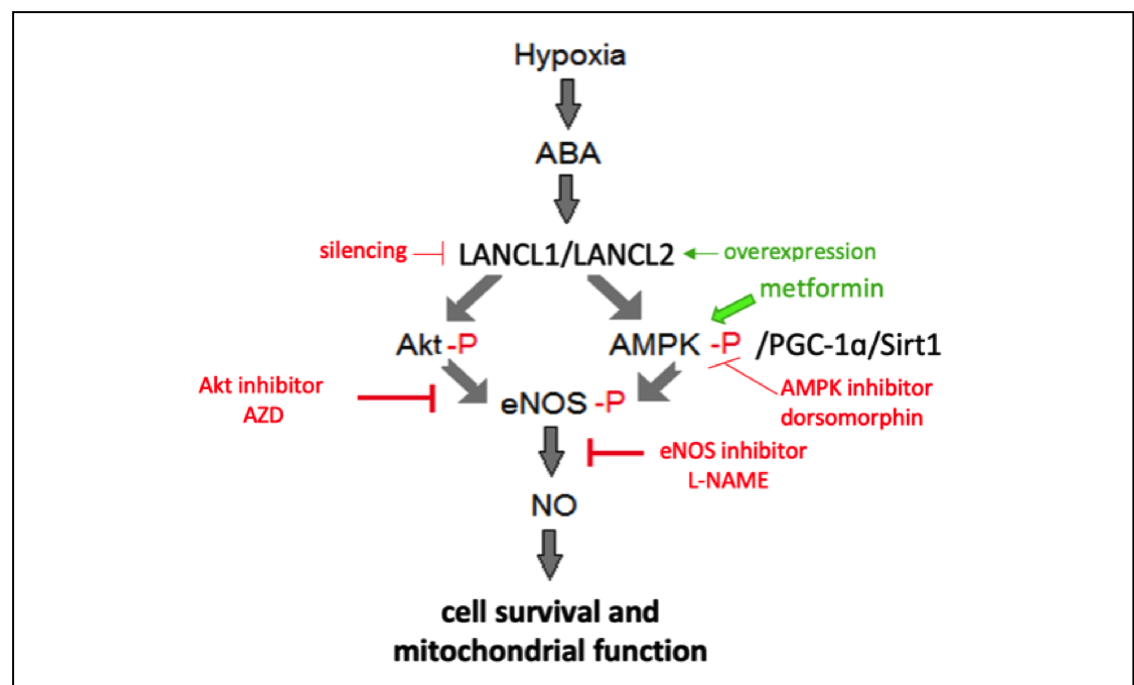
Figure 7. Schematic representation of the role of the ABA-LANCL1/2 system in the response of H9c2 cardiomyocytes to hypoxia. The ABA-LANCL1/2 hormone receptors system is activated by hypoxia in H9c2 cells. Either one of the LANCL proteins can, in turn, activate Akt and the AMPK/PGC- 1 α /Sirt1 pathway. Both phospho-Akt (Akt-P) and phospho-AMPK (AMPK-P) can phosphorylate and activate eNOS, leading to NO production, which exerts beneficial effects on cell viability and on mitochondrial function (oxidative metabolism and maintenance of the proton gradient). The regulatory pathway was probed by overexpressing or silencing the LANCL proteins, inhibiting or stimulating the activity of Akt and AMPK with specific pharmacologic modulators and by inhibiting NO production via L-NAME.